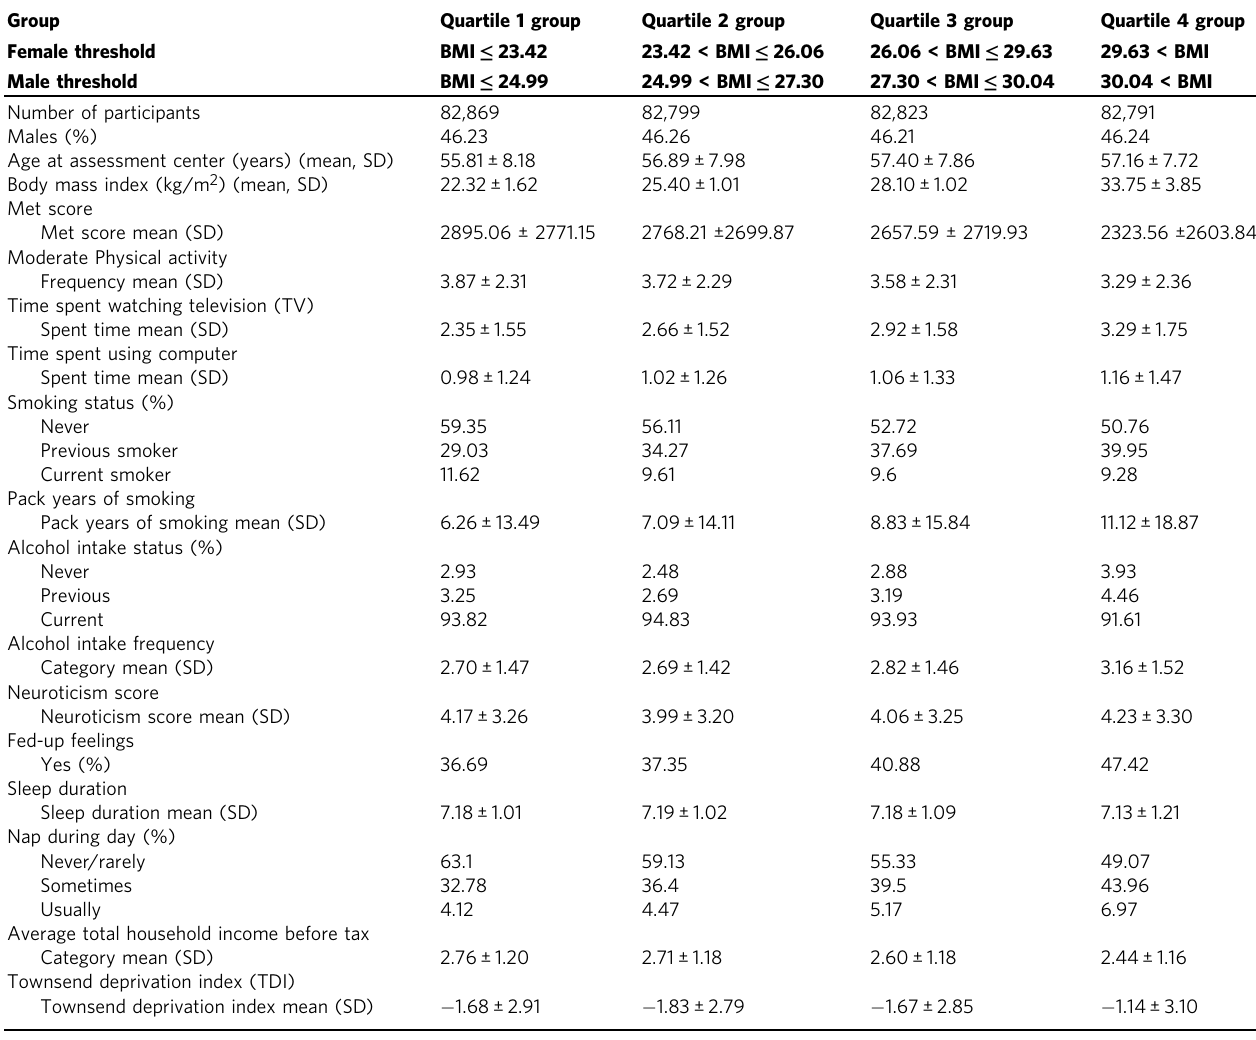
Table 1 Basic characteristics of UK Biobank participants included in this